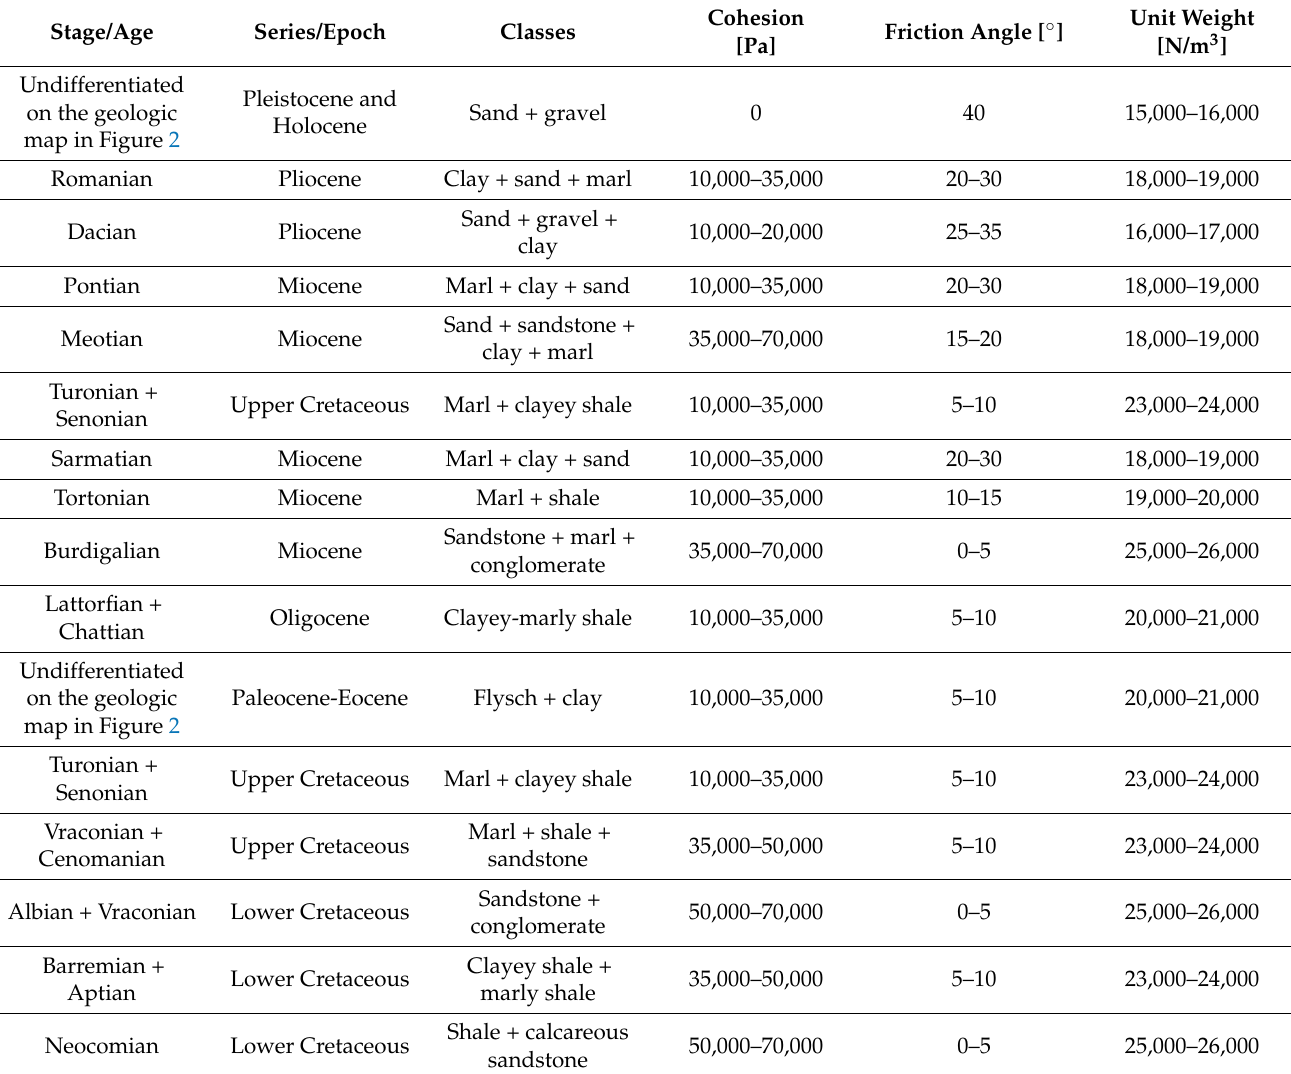
Table 1. Litho-stratigraphic classes and geotechnical parameters used in the study area.